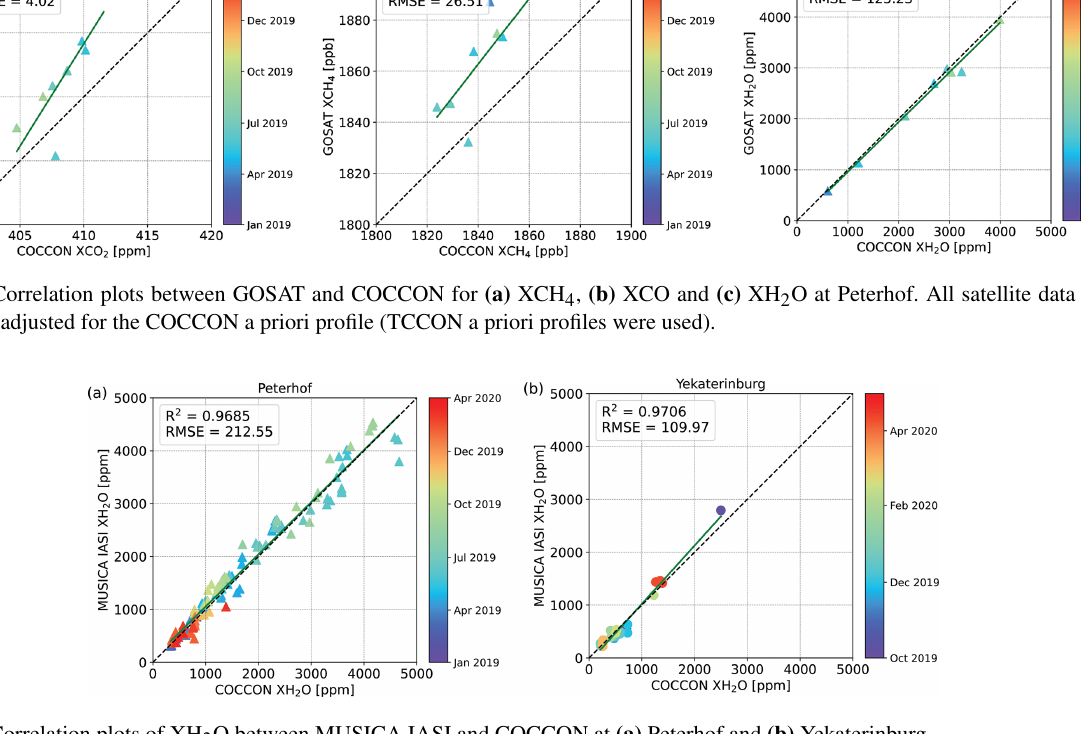
Figure 13. Correlation plots of XH 2 O between MUSICA IASI and COCCON at (a) Peterhof and (b)